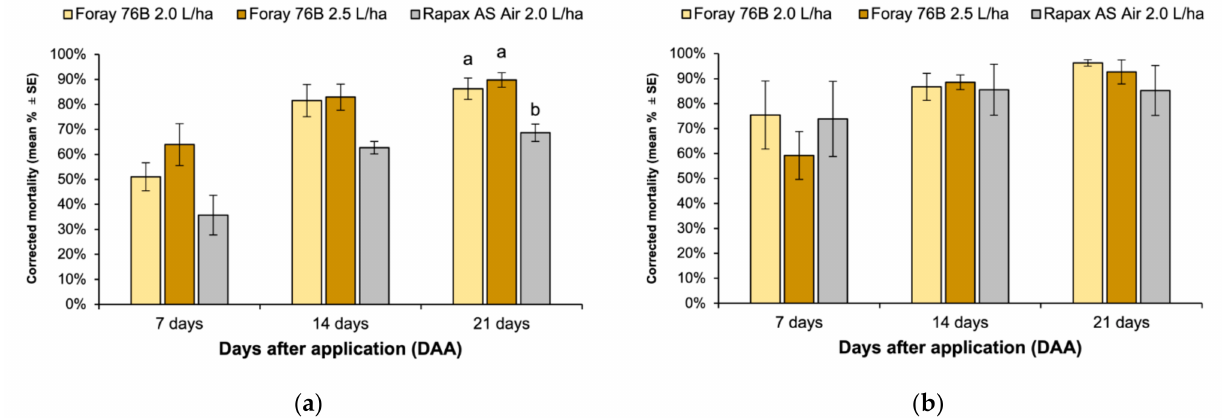
Figure 3. Lymantria dispar mortality (%) under laboratory conditions caused by Foray 76B ® (2.0 L/ha and 2.5 L/ha) and Rapax AVIO ® 7, 14, and 21 days in ( a ) 2018 and ( b ) 2019 panel. Mortality was corrected with the Schneider–Orelli